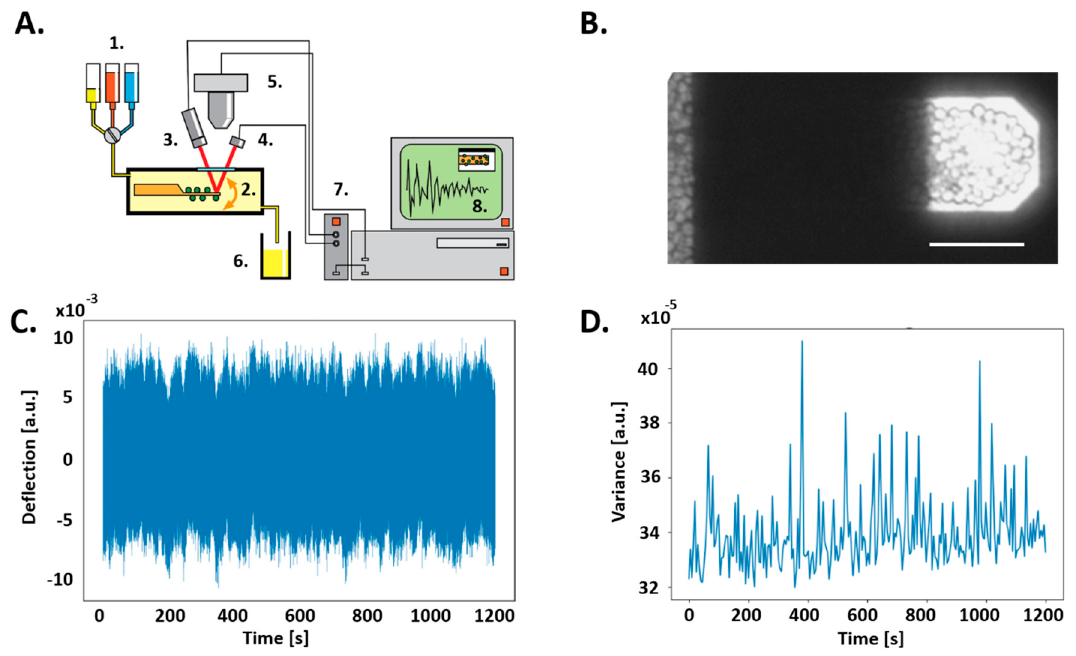
Figure 2. Nano-mechanical sensor system. ( A ) Representative image of a cantilever with attached C albicans cells. Scale bar 40 µm. ( B ) Schematic of the experimental system and data collection. (1) Liquids to be injected into the analysis chamber. In our case YPD, YPD containing fibronectin, and YPD containing caspofungin. (2) Analysis chamber with the AFM cantilever and C. albicans attached onto its surface (green circles). (3) Super luminescent diode. (4) Four-segment photodiode. (5) Optical microscopy with camera. (6) Liquid waste. (7) In-house dedicated electronics and National Instruments data acquisition card. (8) Desktop computer. ( C ). The collected raw data are processed; and ( D ). analyzed using the variance of the signal.